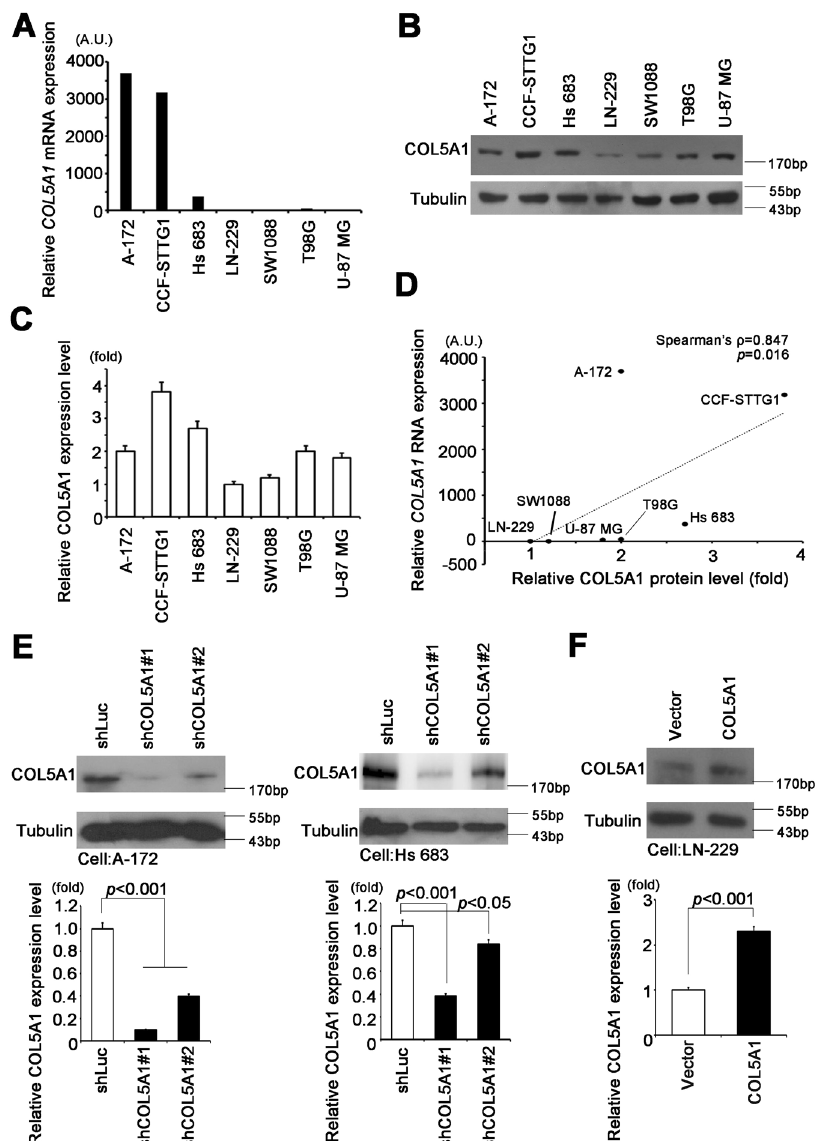
Fig. 3 COL5A1 expression is positively correlated with metastasis ability in GBM cells. A qRT-PCR analysis of COL5A1 expression in various GBM cell lines. B Western blot analysis of COL5A1 and tubulin protein expression in the GBM cell panel. C Quantitative results of COL5A1 in the GBM cell panel. D Correlation plot indicating the relationship between COL5A1 mRNA and protein expression levels (Spearman ’ s rho = 0.733, p = 0.025). E Western blot analysis and quantitative results of COL5A1 knockdown in A-172 and Hs 683 cells. F Western blot analysis and quantitative results of COL5A1 overexpression in LN-229 cells. Tubulin was used as an internal control for protein loading. The signi fi cance of the difference was analyzed using the nonparametric Mann – Whitney U test. The AU represents absorbance